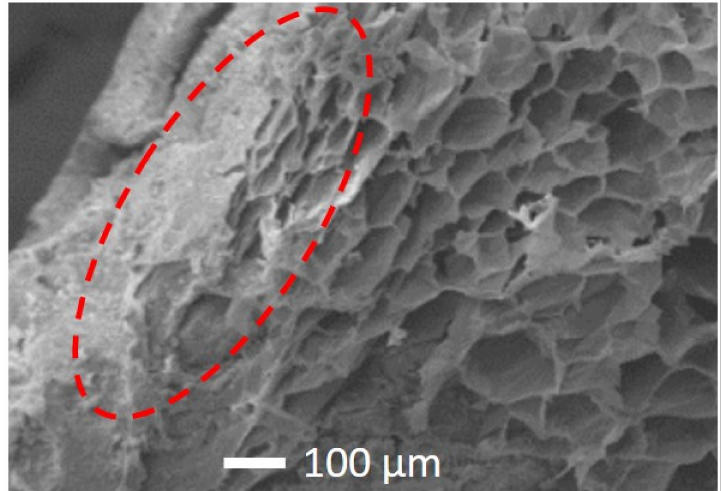
Figure 3. SEM image of D(EPS)